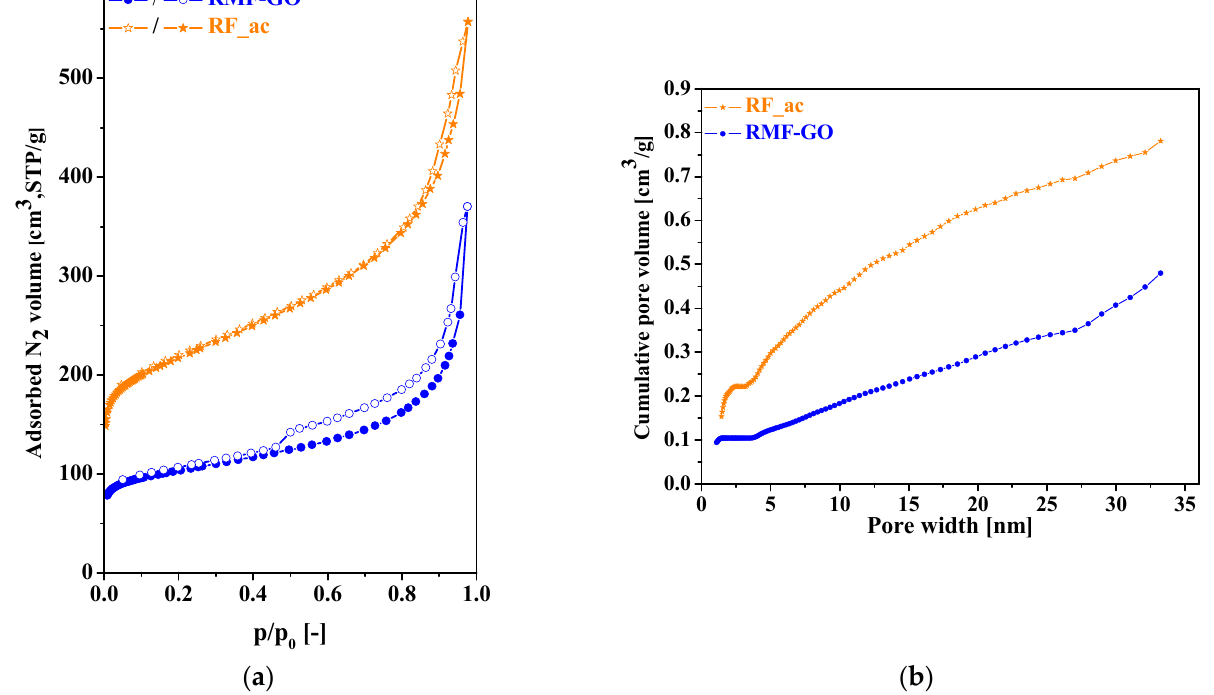
Figure 2. Low-temperature nitrogen adsorption/desorption isotherms (full symbols: adsorption, empty symbols: desorption branch) ( a ) and integral pore size distribution (from adsorption branch, QSDFT) ( b ) of the two carbons, RF_ac (stars, orange) and RMF-GO (dots,